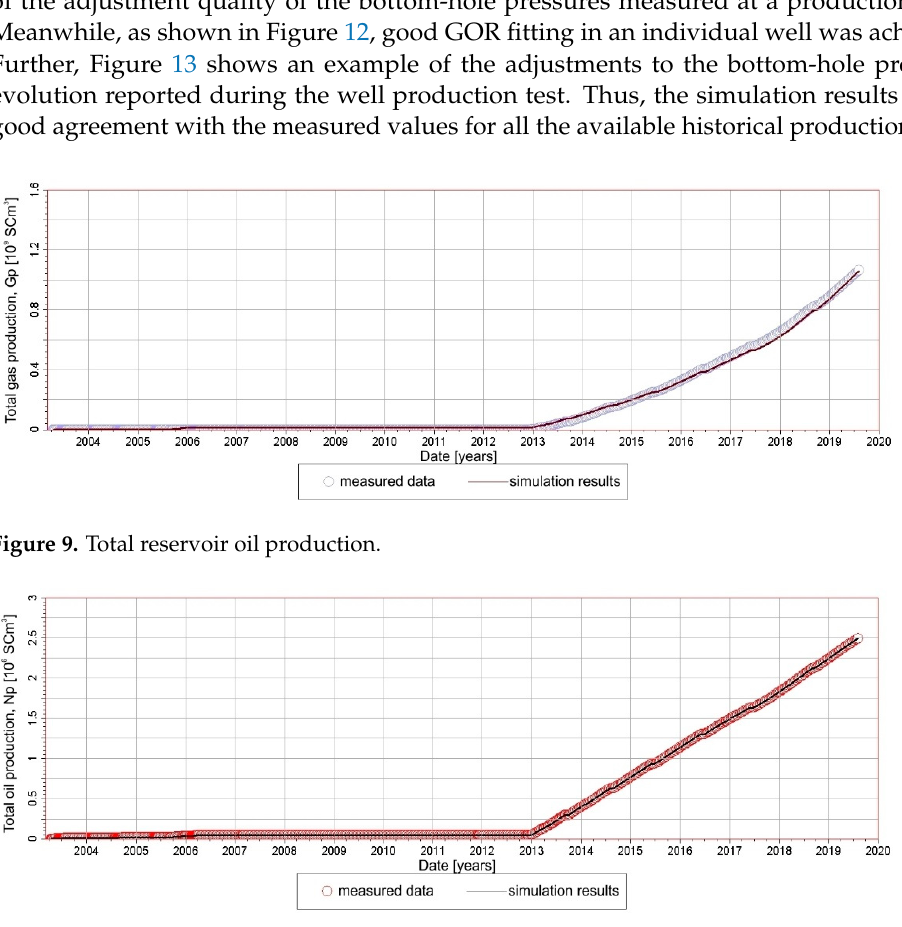
Figure 8. 3D view of the model top layer of the original gas saturation.